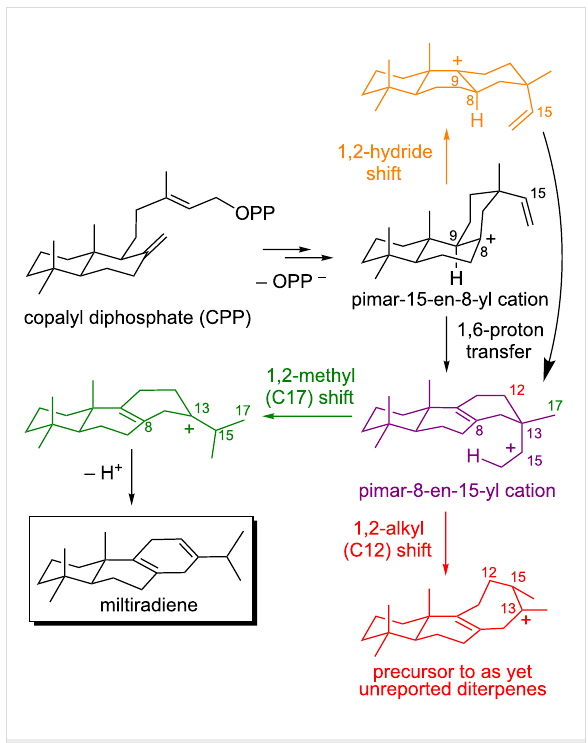
Figure 10: Carbocation rearrangements involved in miltiradiene forma-